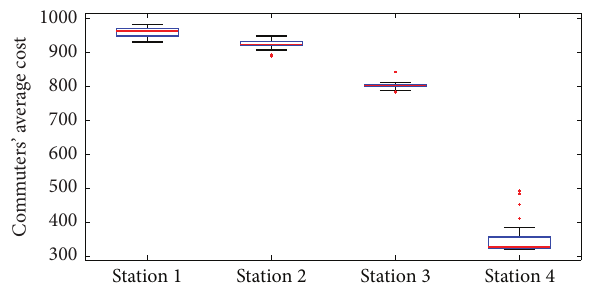
Figure 8: Commuter’s average cost of each station.